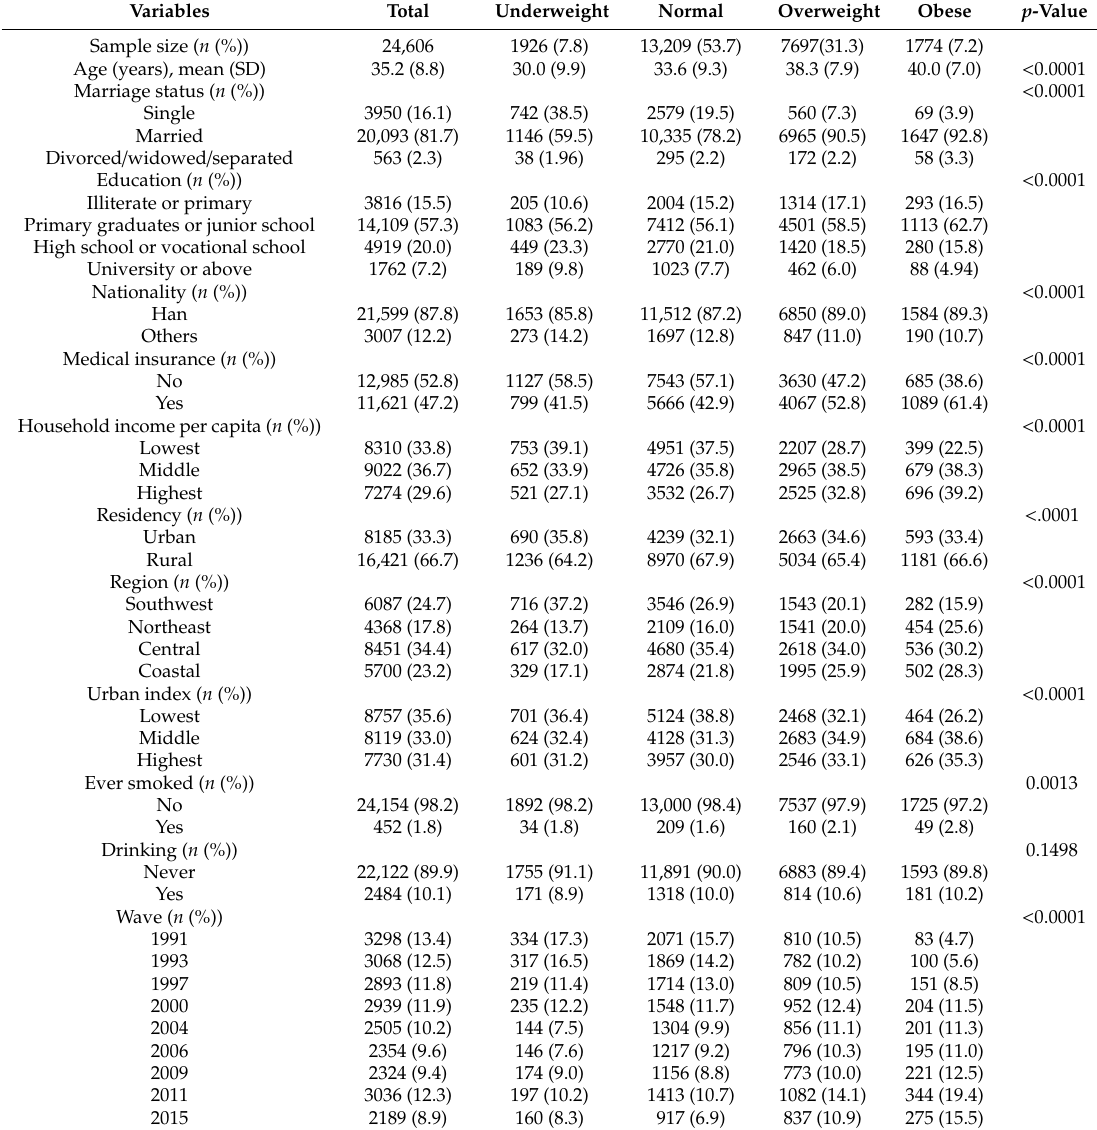
Table 1. Distribution of women of reproductive age across four categories of malnutrition by di ff erent predictors from the China Health and Nutrition Survey (CHNS)